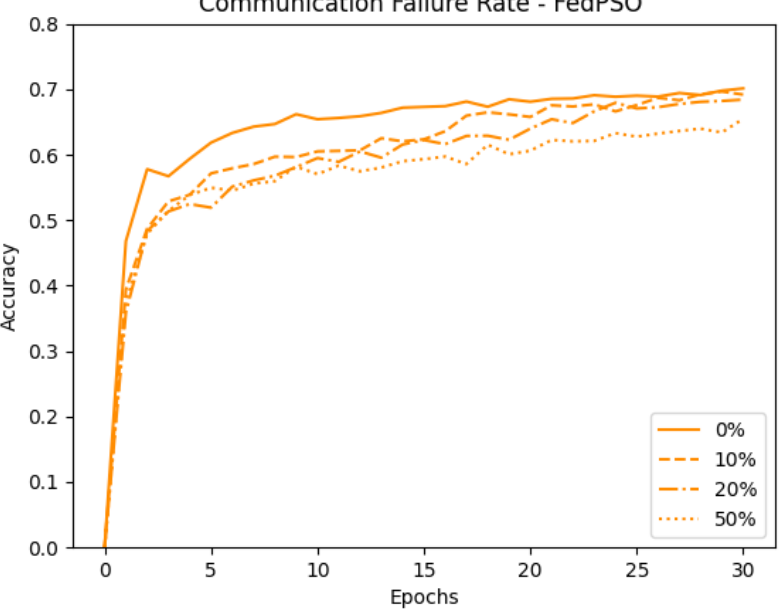
Figure 8. Comparison of FedPSO test accuracy in unstable network